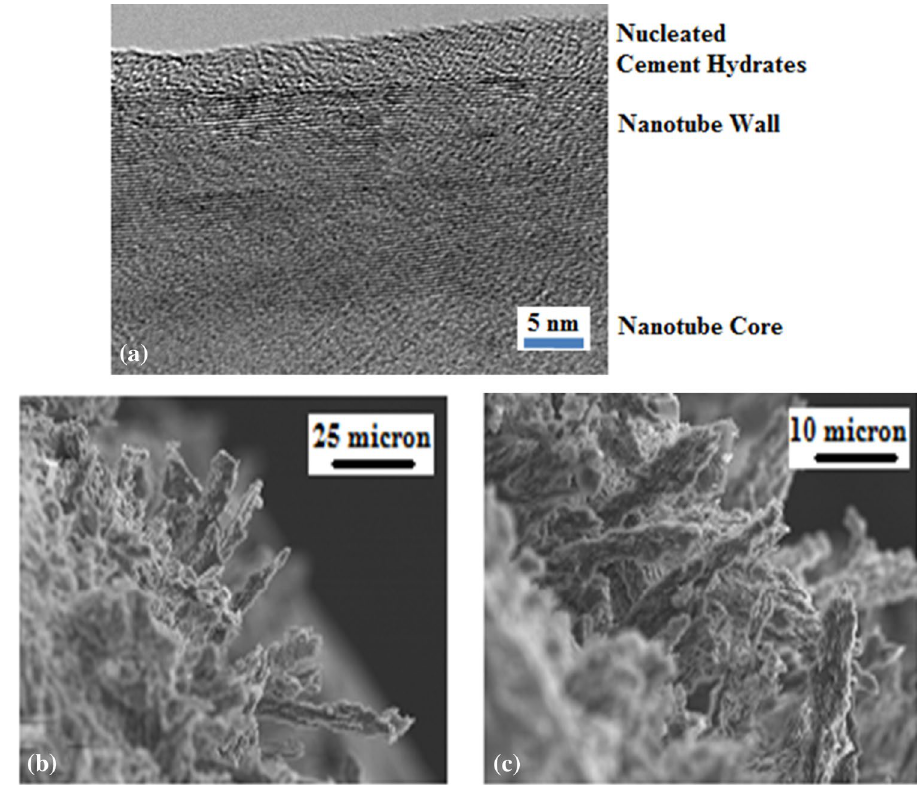
Fig. 10 TEM image a and SEM images b - c of the fractured surface of a UHPCM with 0.03 wt.% of acid-functionalized